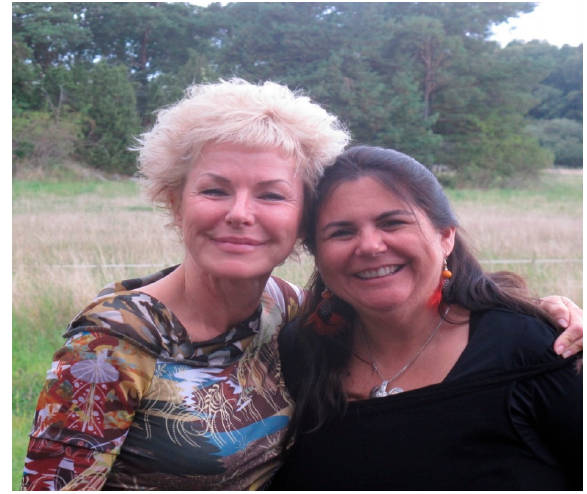
Figure 6. The authors in Sweden.